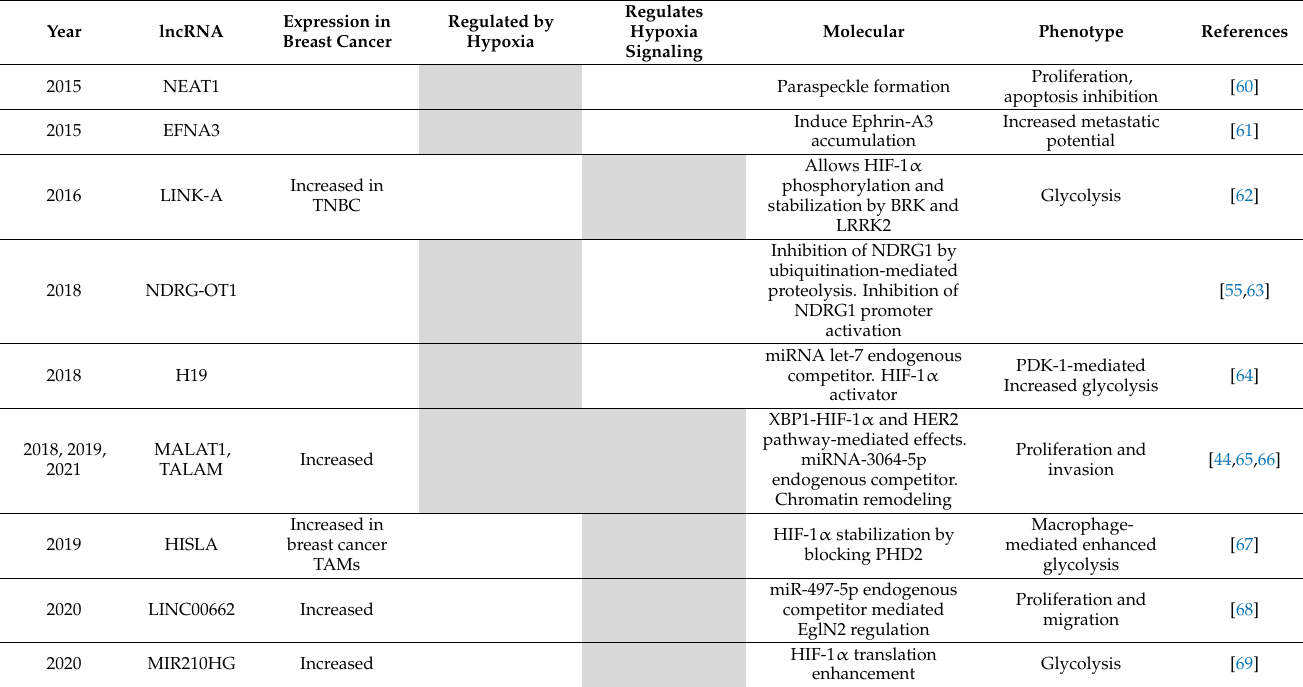
Table 1. Hypoxia-related lncRNA in breast